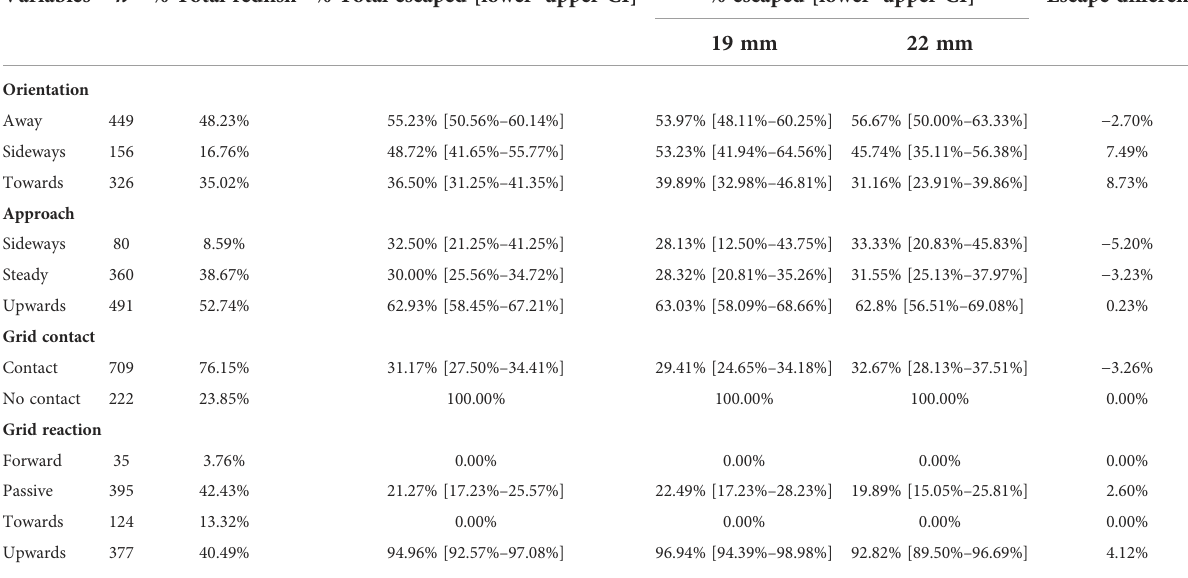
TABLE 3 Fate of juvenile red fi sh in 19- and 22-mm bar spacing Nordmøre grids for the different